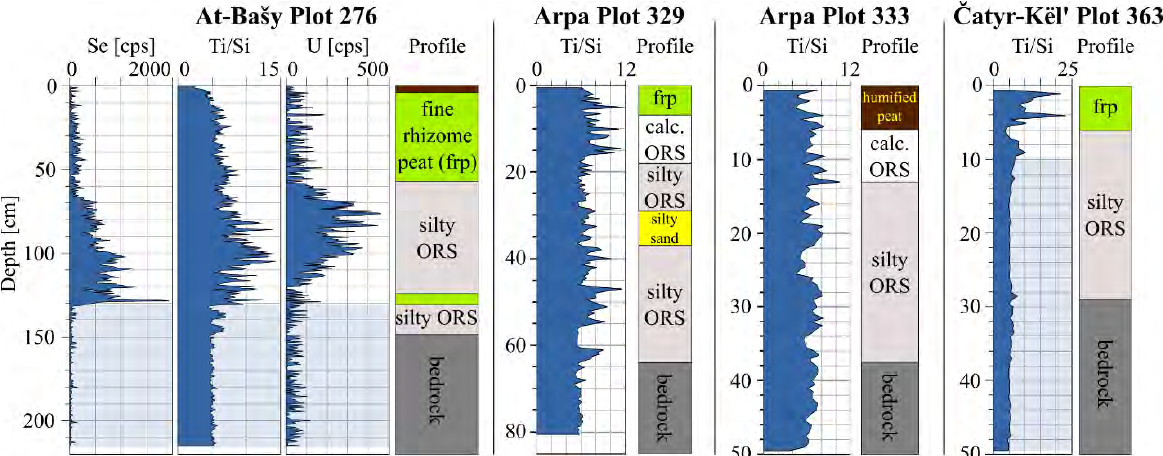
Figure 9. Vertical distribution of the mass fraction of selenium and uranium as well as the titanium/silicon ratio in the peatland cores. The stratification of each plot is displayed on the right side. To provide an overview, cores from all three peatlands are